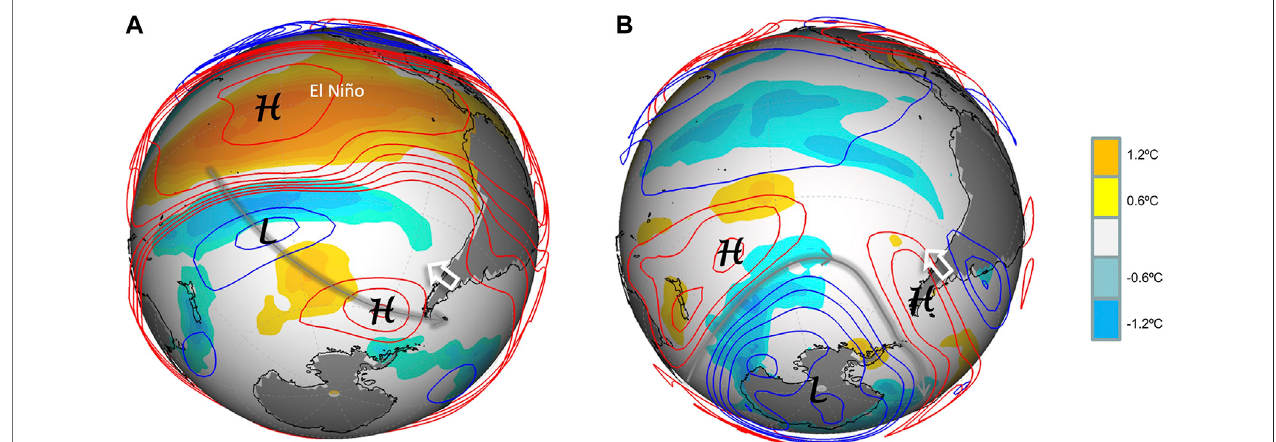
FIGURE 11 | (A) Sea surface temperature anomalies (shaded) and 200 hPa geopotential height anomalies (contoured every 25 m: positive in red, negative in blue contours) during El Niño austral summer (Dec-Feb). (B) As (A) but for summers with the Southern Annular Mode (SAM) in its positive phase (SAM Index > 1). Note how both modes produce easterly wind anomalies over the Austral Andes (white arrow) conducive to dry conditions in the otherwise hyper humid western Patagonia.